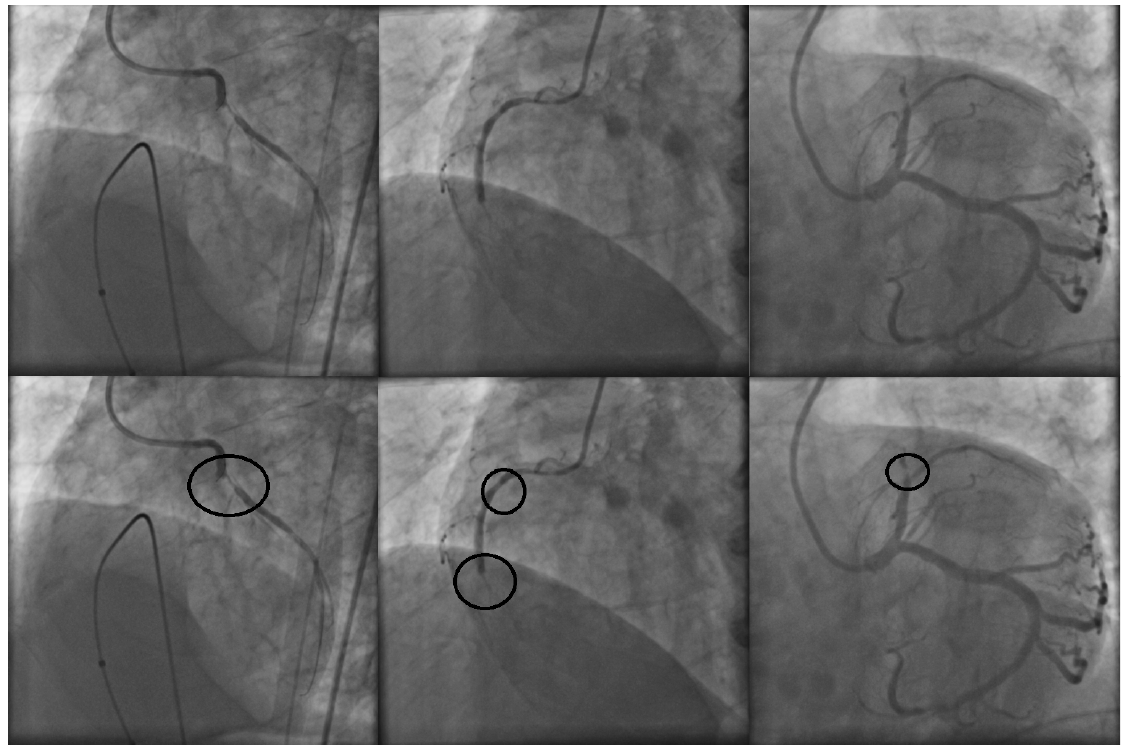
Figure 1. X-ray coronary angiograms in the first row and their respective stenosis areas labeled by the specialist in the second